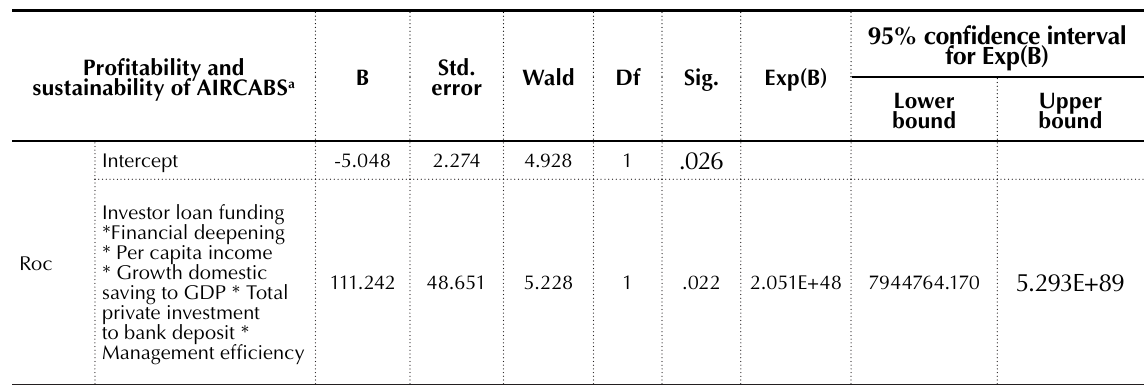
Table 28. Parameter estimates of profitability and sustainability of